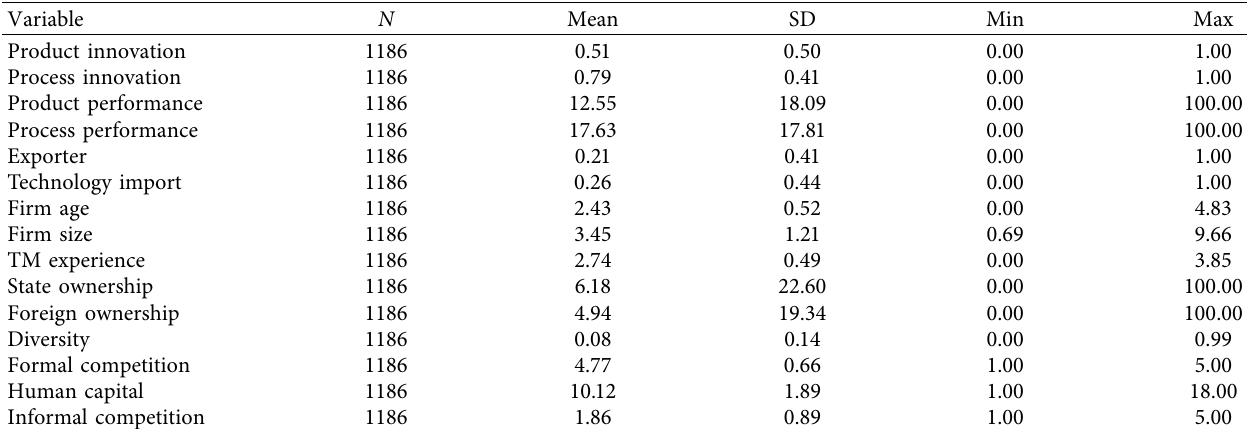
Table 2: Description